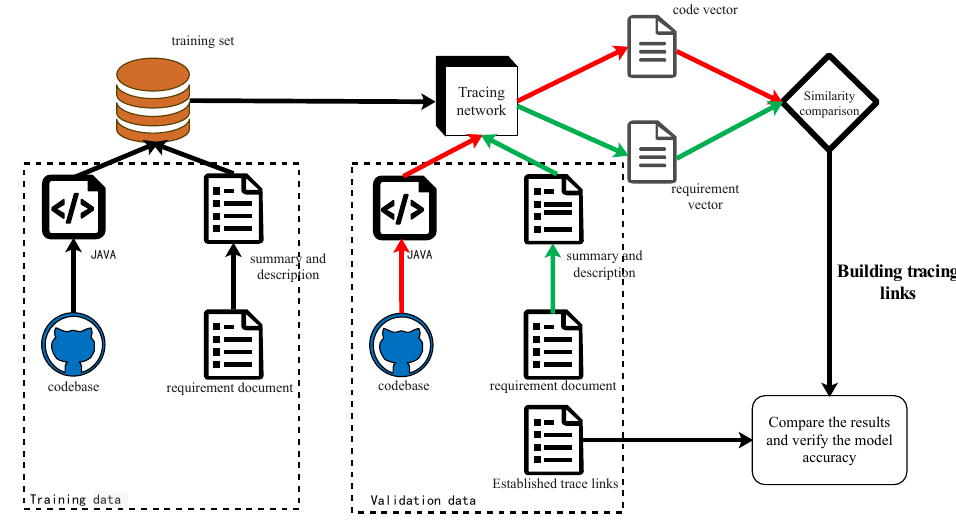
Figure 6. Overall experiment process of